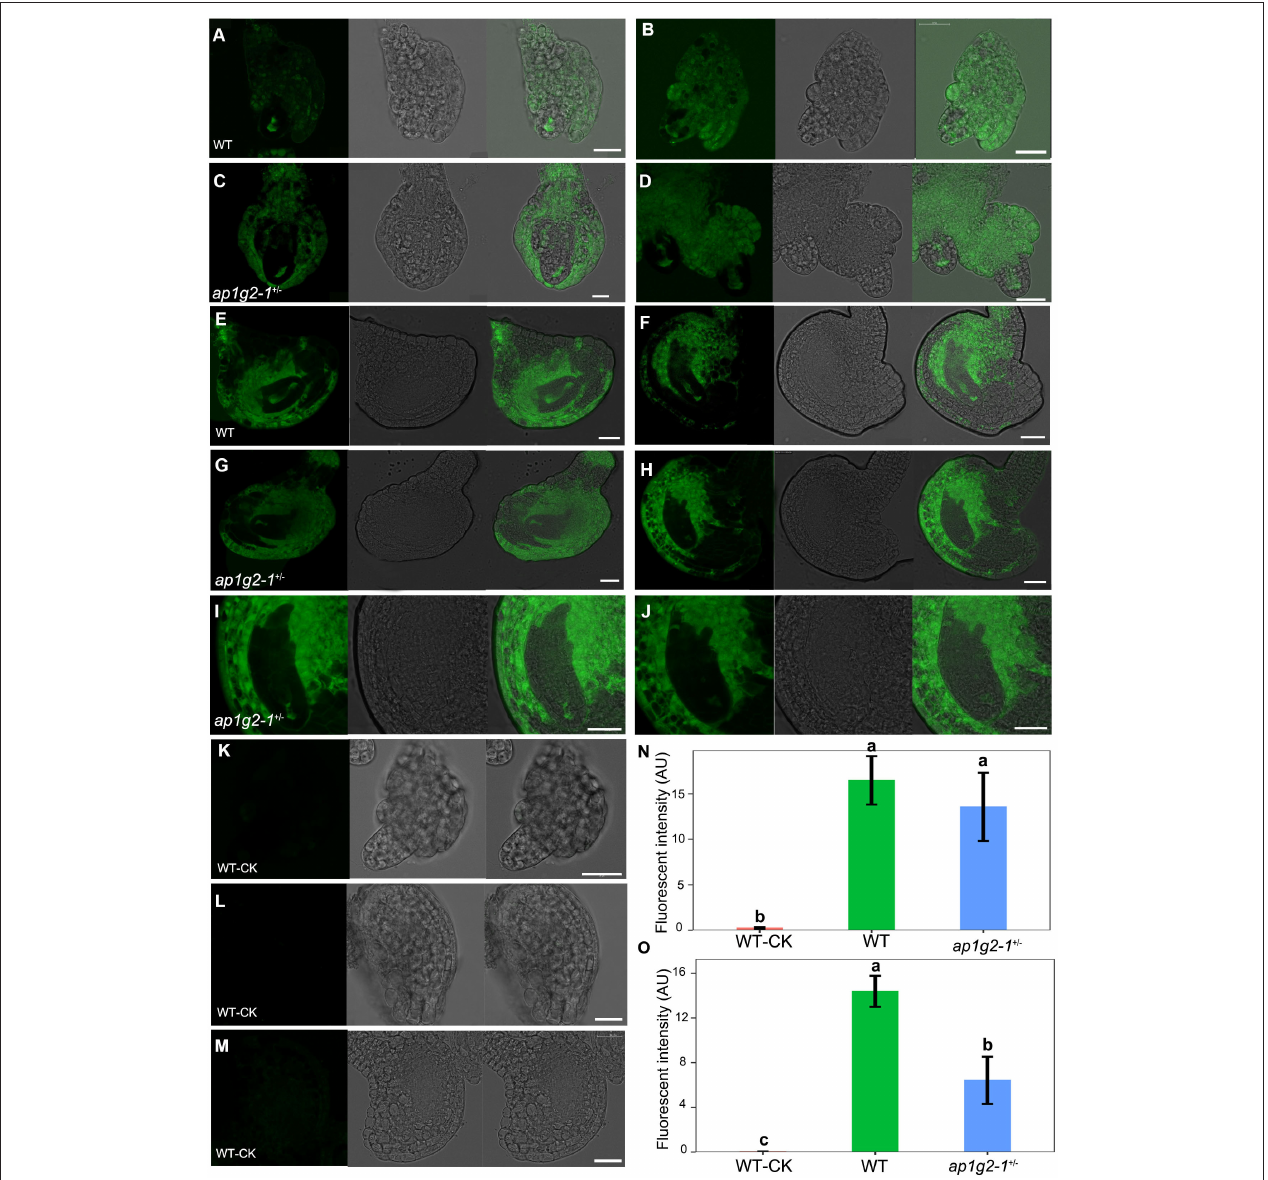
FIGURE 9 | Calcium dynamics during female gametogenesis in WT and ap1g2-1 + / − . (A,B) and (C,D) ovules at FG1 from WT and ap1g2-1 + / − dyed by an intracellular calcium ion concentration fluorescent probe. (E,F) ovules around at FG3 and FG4 from WT, respectively. (G,H) Aborted embryo sacs from ap1g2-1 + / − . (I,J) were magnification of (E,F) . (K–M) were the ovules from the wild type without dyeing. (N) Quantification of the Ca2 + level in ovules of WT and ap1g2-1 + / − at the FG1 stage. (O) Quantification of the Ca2 + level in ovules at later stages from WT and aborted ovules of ap1g2-1 + / − . Bar = 20